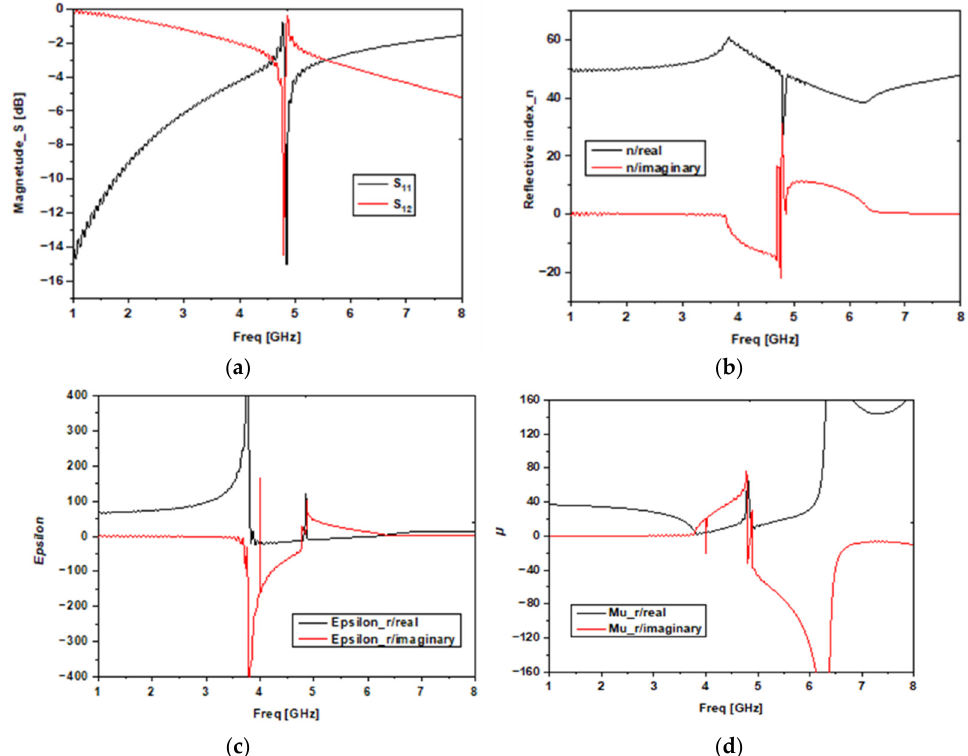
Figure 7. The unit cell results: ( a ) simulated S-parameters, ( b ) refractive index, ( c ) effective permittivity, and ( d ) effective permeability.